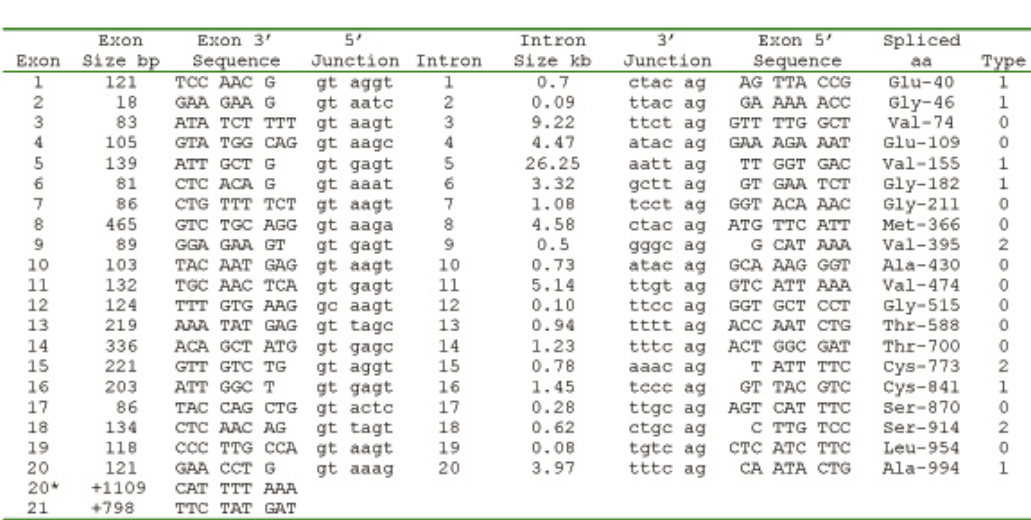
Exon and Intron Organization of the Human SERCA2